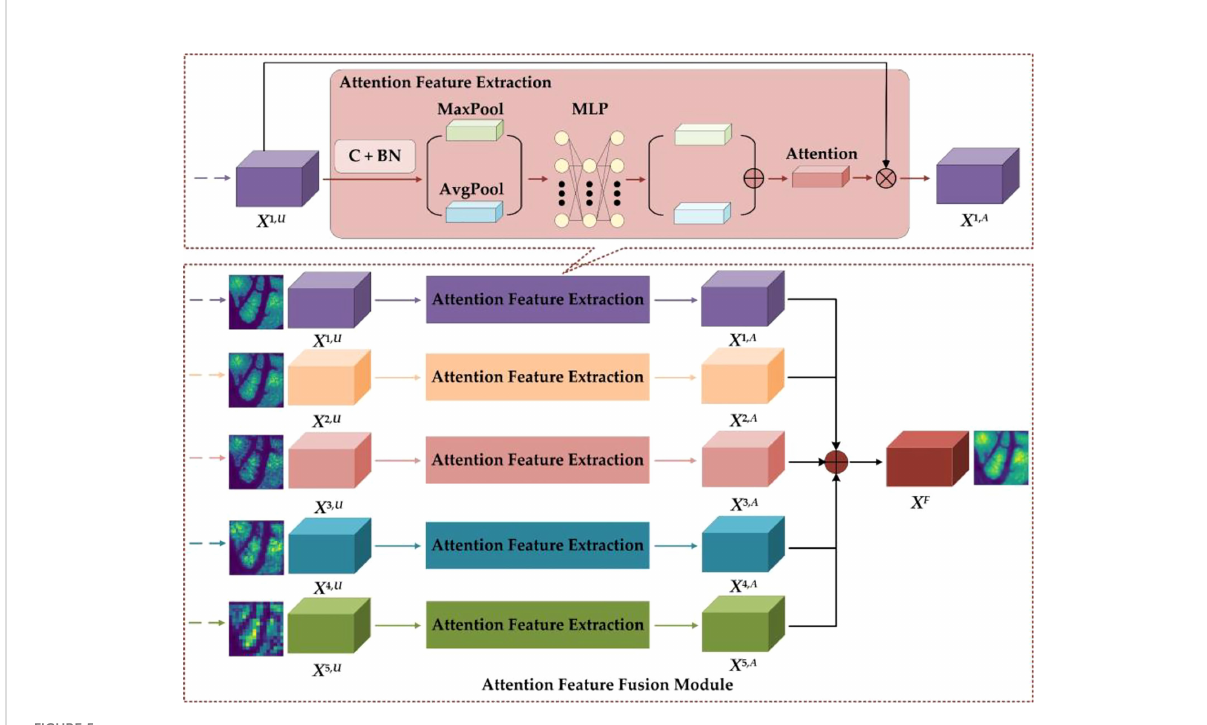
FIGURE 5 Details of the